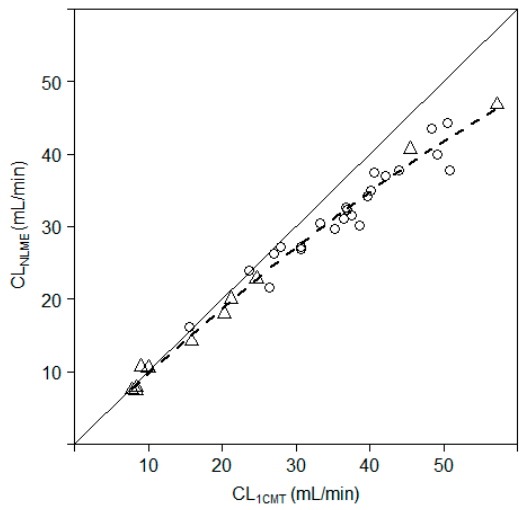
Figure 3. Comparison iohexol plasma clearance based on NLME (CL NLME ) and a one-compartment pool model (CL 1CMT ). Dotted line, nonlinear regression line; solid line, line of unity; triangles, goat; circles, pig.